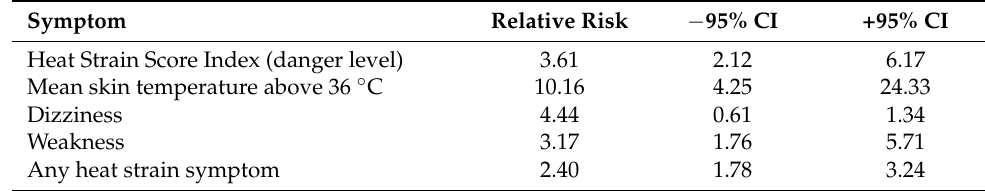
Table A3. Differences in psychophysical parameters between indoor and outdoor